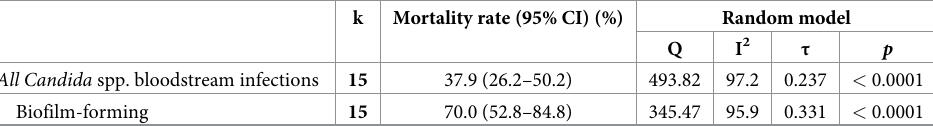
k, Number of studies; Q, I 2 and τ , Heterogeneity indexes; p , Random effect model significance level. Mortality rates